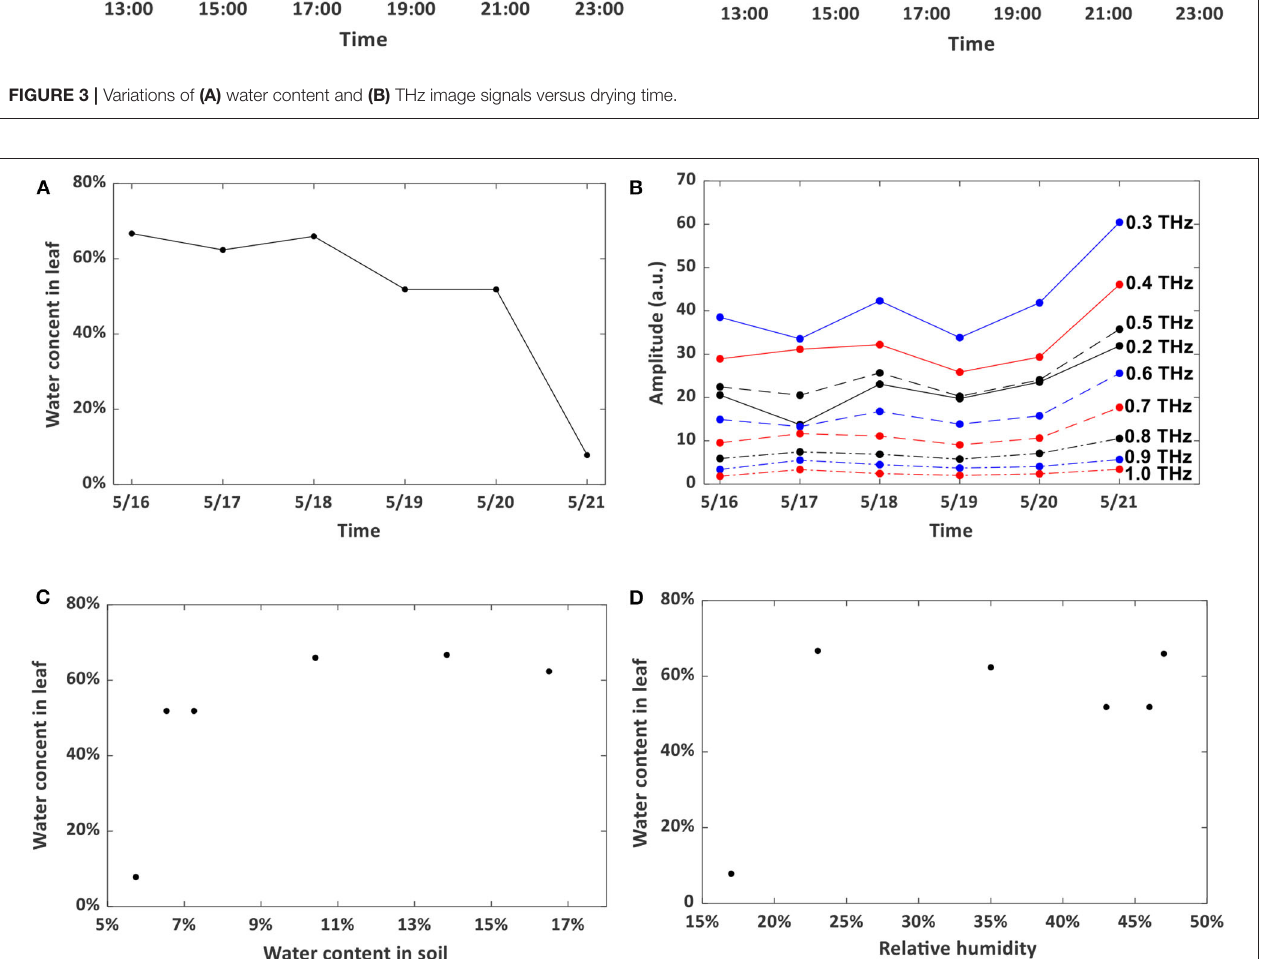
basal, intermediate, and distal regions at the same time, which implies that the water loss speed in the basal region is higher than others. This agrees well with the results in [35]. Here, we can also confirm that the THz transmission can be affected by both the water content and the measurement spot, which is investigated in [36]. Different spot